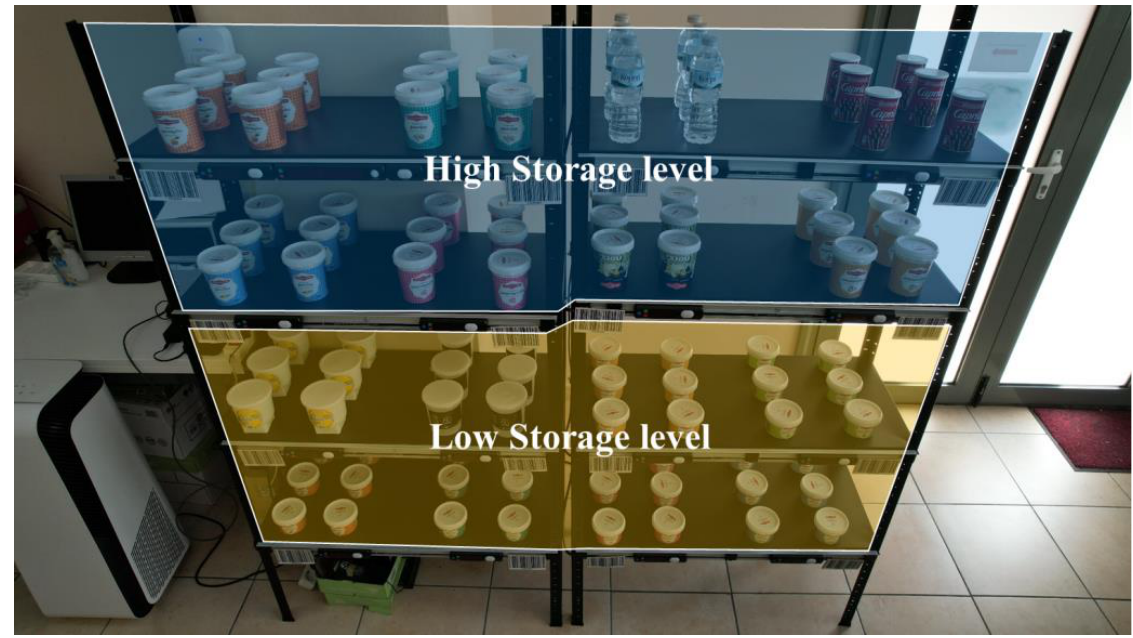
Figure 5. Overview of storage levels.